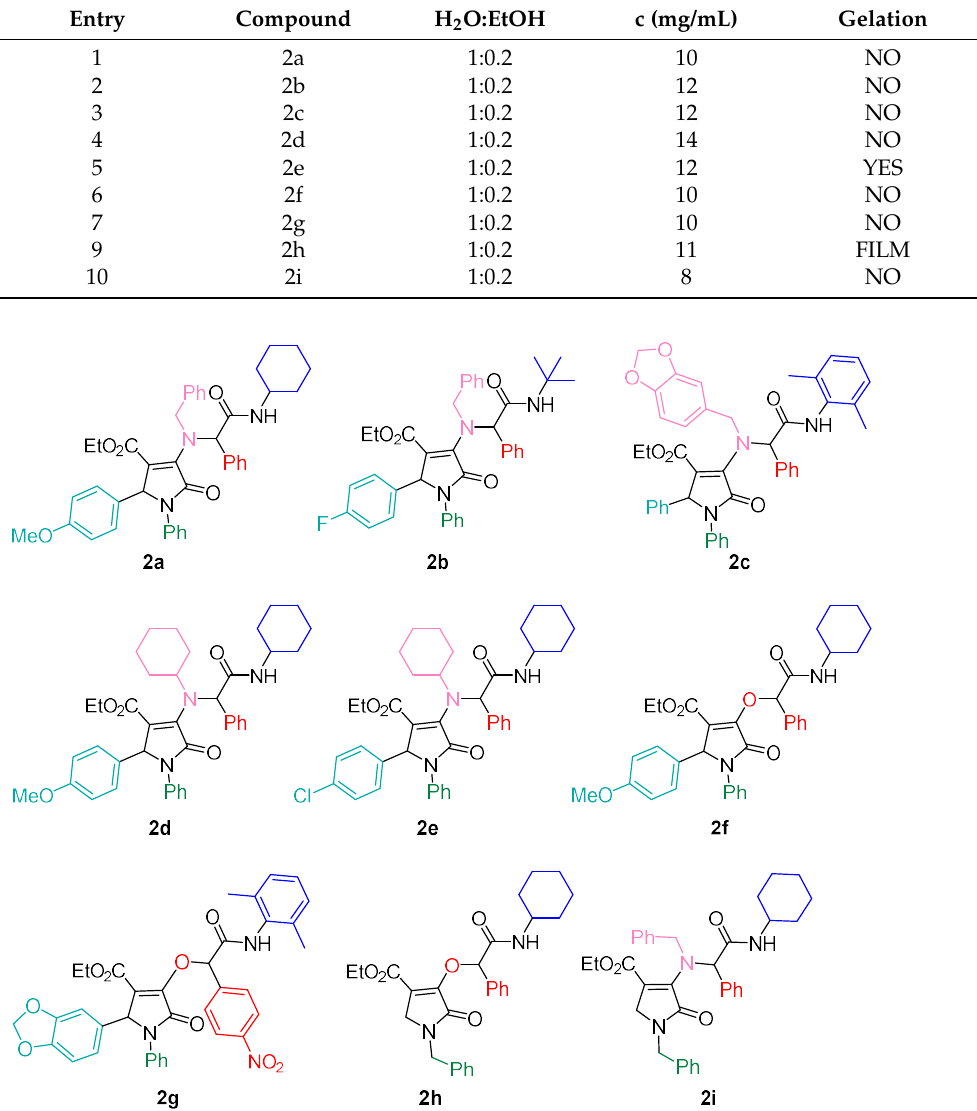
Figure 4. Peptidomitic pyrrolidinone derivatives tested as gelators. Table 2. Gelation test of peptidomimetics 2a–i.